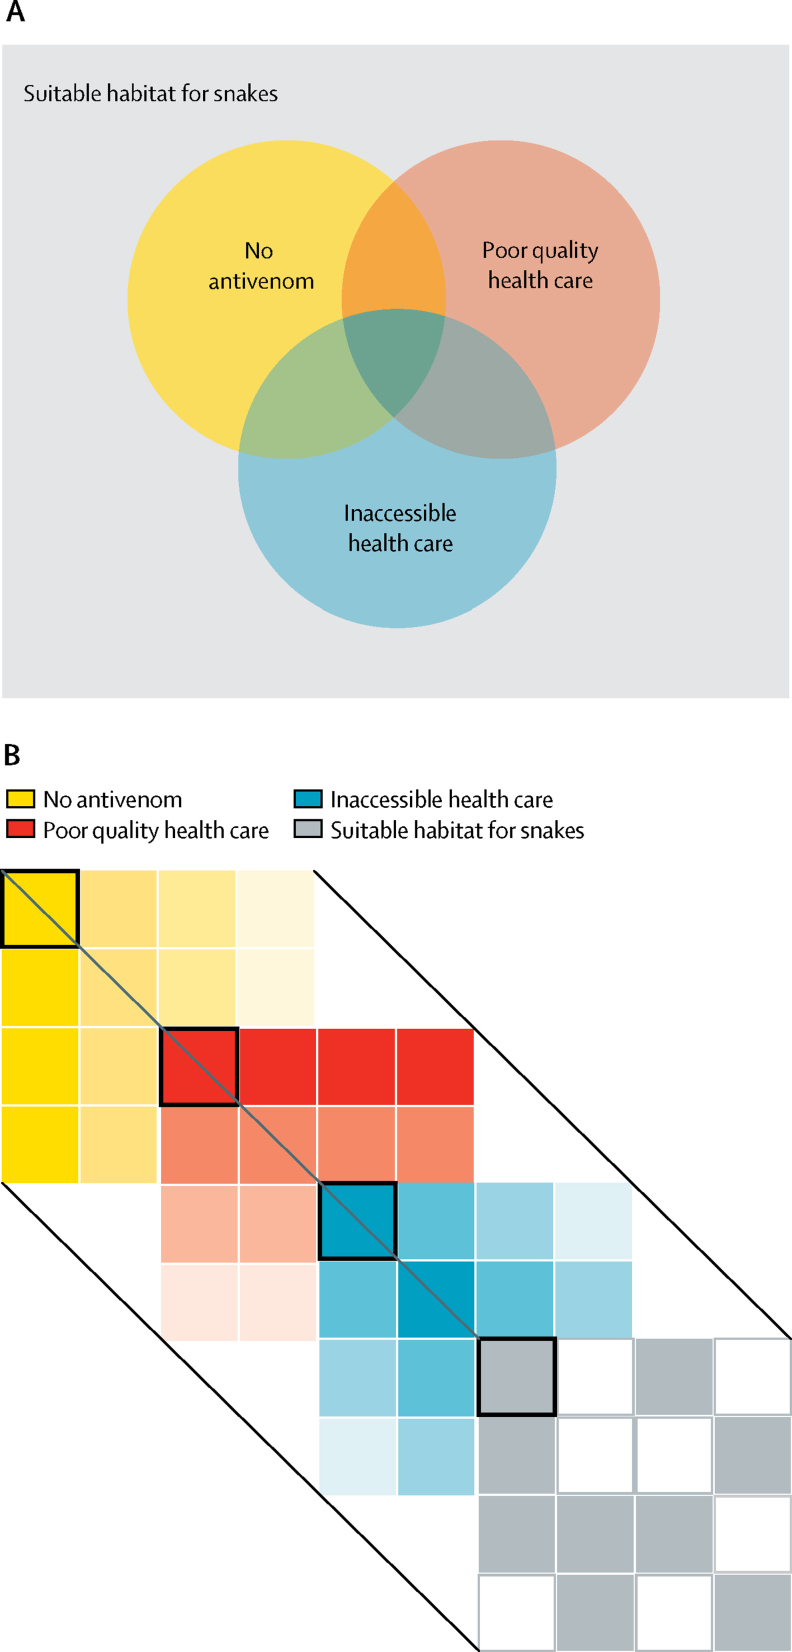
Conceptual overview of vulnerability to snakebite envenoming(A) Vulnerability can be considered as the intersection of populations who live within the range of venomous snakes that have no antivenoms available, cannot easily access health care, and have poor quality health care in delivery of antivenoms or ensuring necessary stocks. The intersection of all three defines the most vulnerable populations. (B) These factors vary in space. By overlaying these features, the most vulnerable populations can be identified spatially (represented here by the boxes outlined in black).